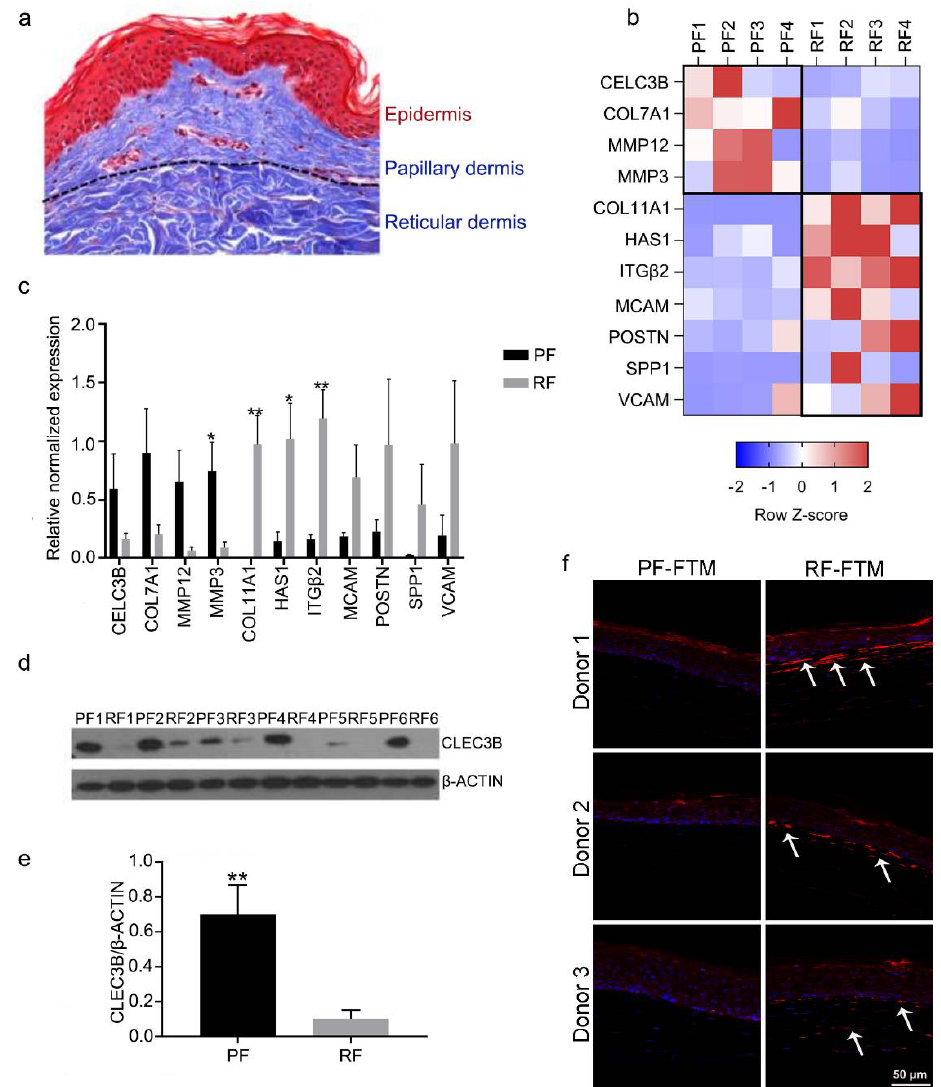
Figure 1. Distinct expression profiles of PFs and RFs. ( a ) Masson trichrome staining of normal human skin. ( b ) Heatmap of 11 differentially expressed genes in PFs and RFs on mRNA level, N = 4. ( c ) The mRNA expression of 11 differentially expressed genes in PFs and RFs, N = 4. ( d ) The protein expression of CLEC3B in PFs and RFs by Western blot, N = 6. ( e ) The Western blot quantification of CLEC3B and β-ACTIN. ( f ) The expression of COL11A1 in PF-FTMs and RF-FTMs by IF staining, N = 3. Positive staining is indicated by arrow as an example. Data is presented as mean ± standard deviation (SD); * p < 0.05, ** p < 0.01.